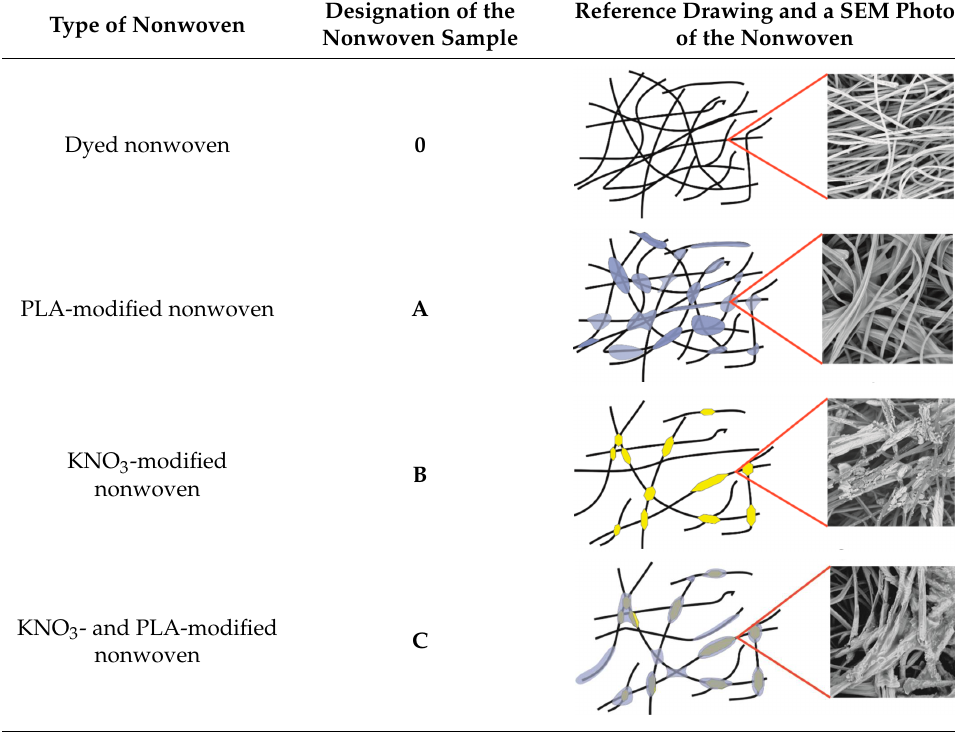
Figure 1. Photograph of the nonwoven ( a ) before the dyeing process; ( b ) dyed nonwoven. Table 1. Designations of modified viscose nonwovens.